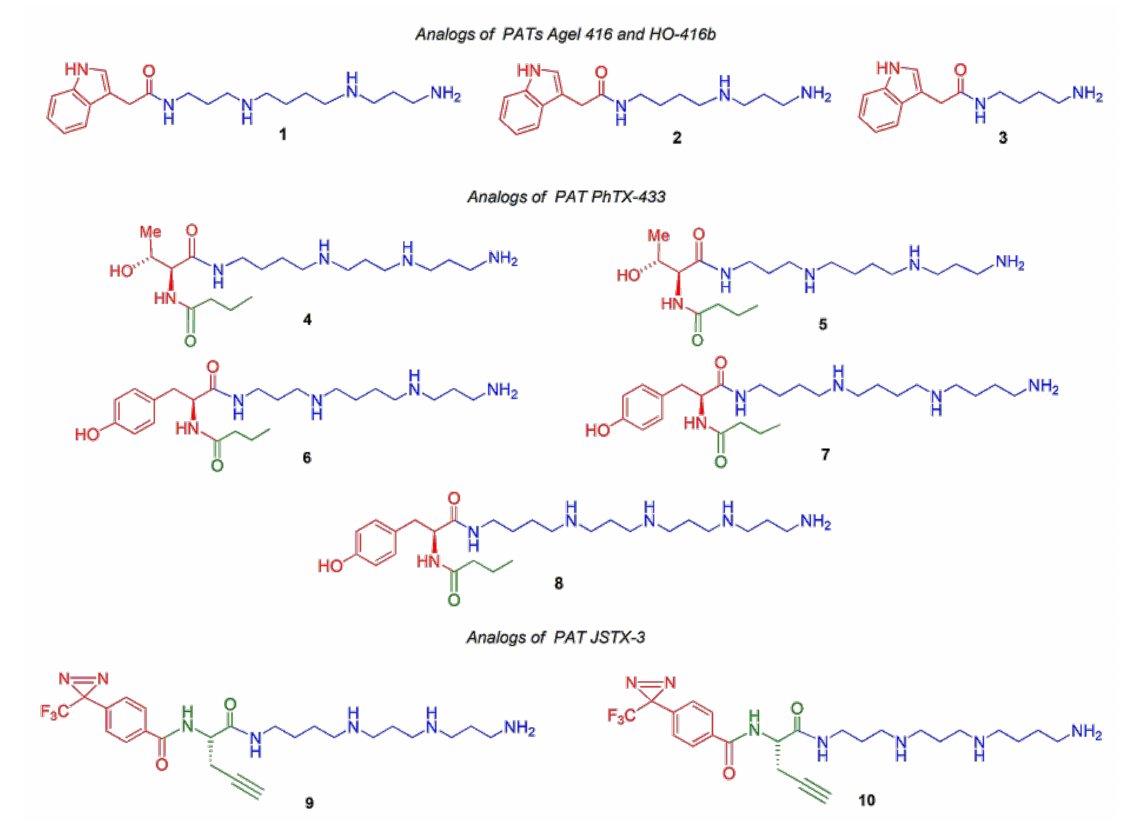
Figure 2. Structures of synthesized PAT analogs in the context of the present